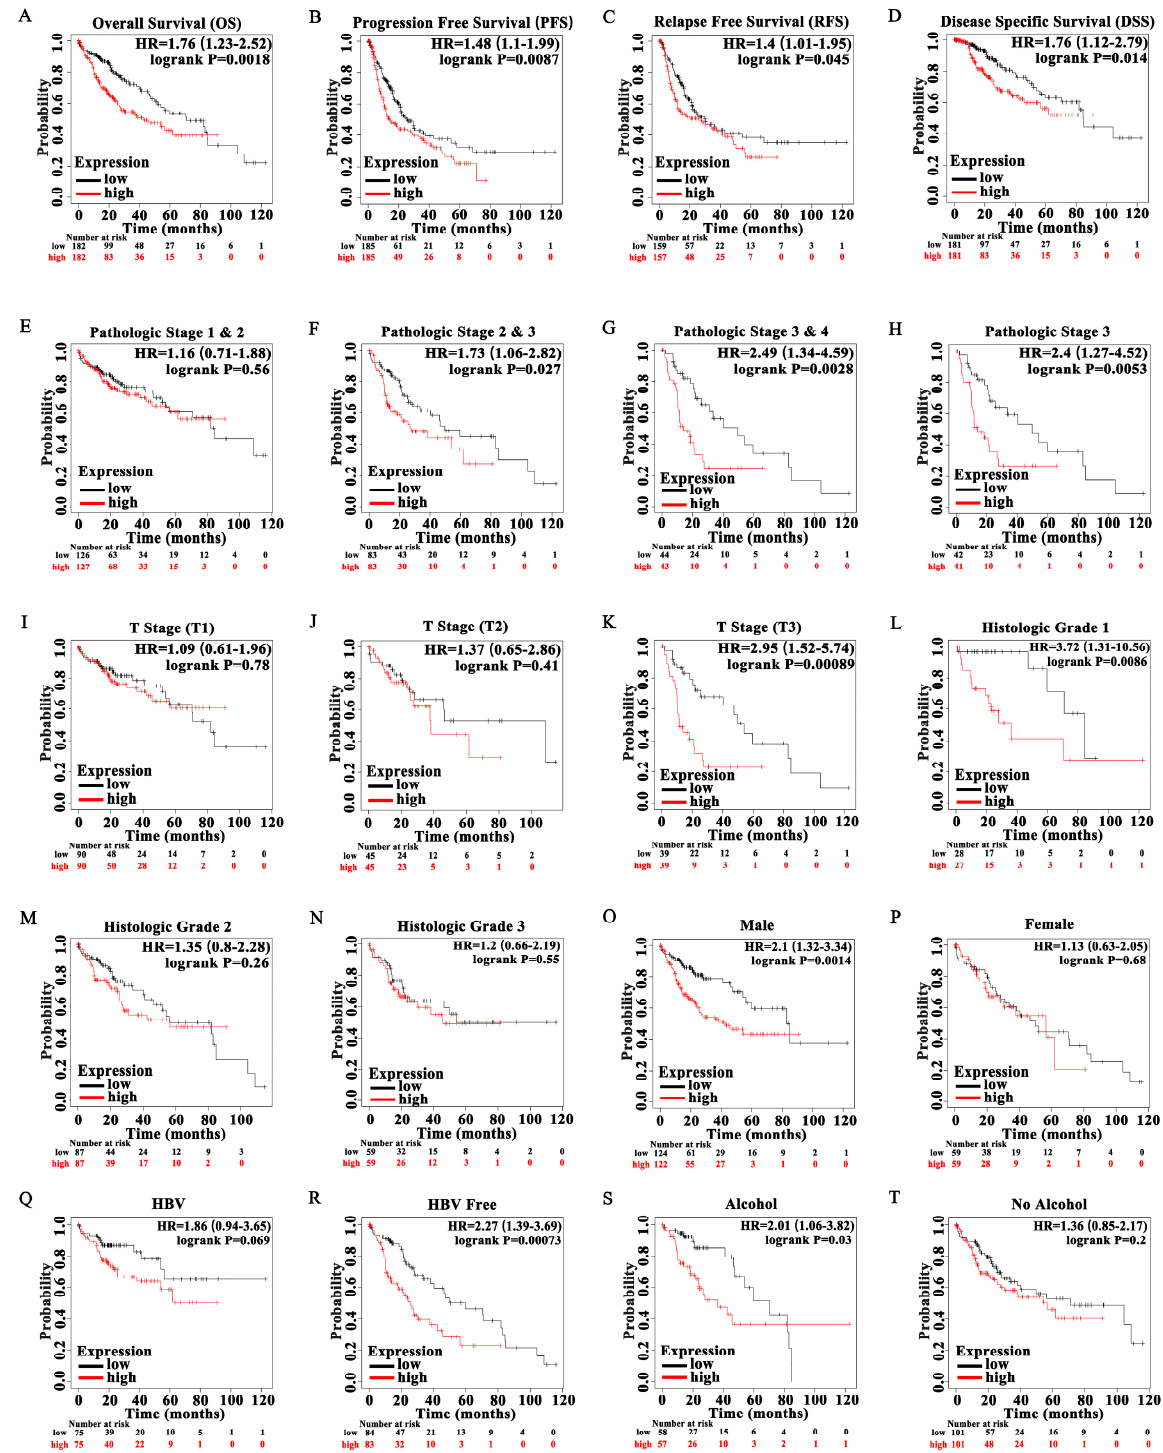
Commented [M21]: Please replace with a shaper image. There are no underlines and the legend of “high” in the some figures Commented [ 许 22R21]: The figure is modified.